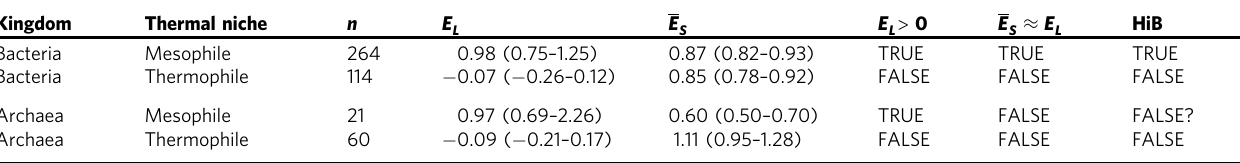
Estimated mean intra-speci fi c (short-term, E S ) and inter-speci fi c (long-term, E L ) thermal sensitivities (95% CI ranges in parentheses)for bacteria and archaea split by thermal niche (also see Fig. 3). As the samedataare used tocalculate E S and E L , the numberof datapoints( n ) appliesto both. Thelastcolumn indicates whetherornot the HiBhypothesisis supported.TheHiBresult forarchaea maybe ambiguous, as described in the Results and Discussion